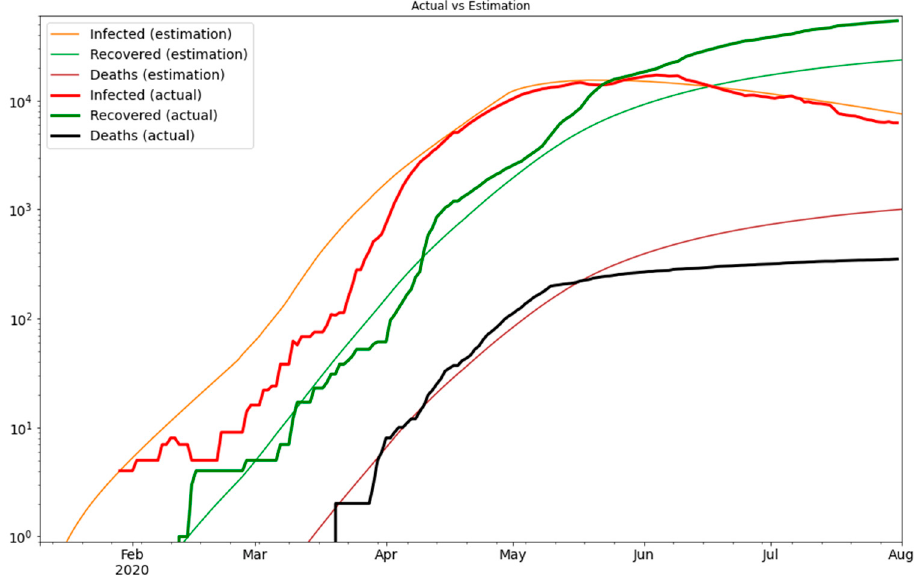
Figure 3. The optimization result on the logarithmic scale.